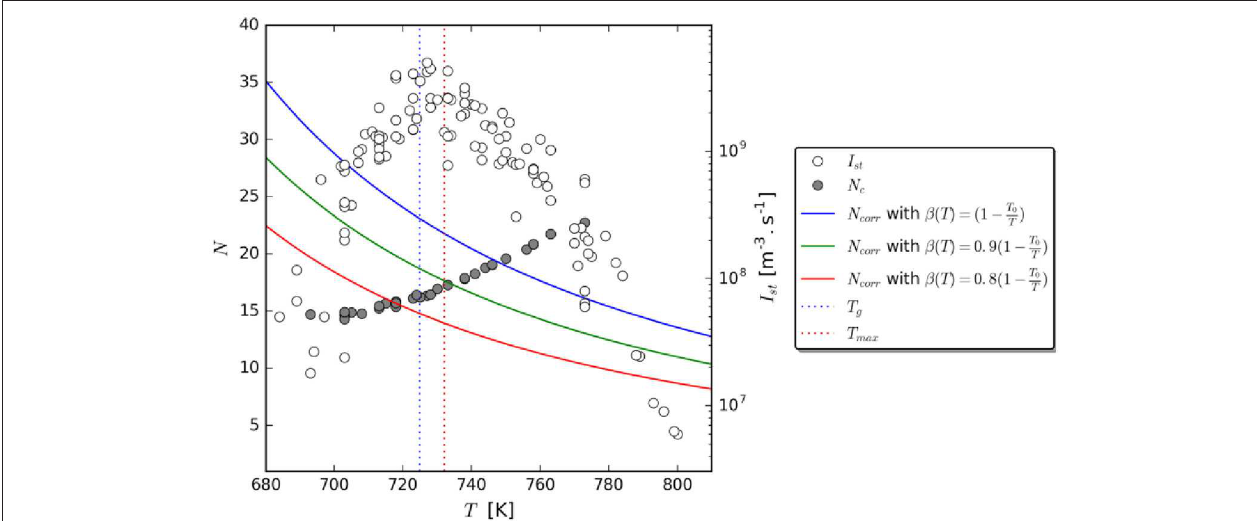
FIGURE 1 | N C (T) and N Corr ( T ) vs. temperature. Upper, average, and lower boundaries for N corr are shown (solid lines). I st = experimental steady-state nucleation rates for Li 2 O.2SiO 2 . The two vertical lines indicate the temperature T max ( ∼ 732K) of maximum nucleation rate, and the glass transition temperature, T g ( ∼ 725K), where the viscosity is10 12 Pa · s. N C = calculated number of atoms in the critical nucleus utilizing experimental nucleation rates and CNT. N corr = estimated number of correlated units in the CRR (reprinted from [19] with permission from AIP Publishing).